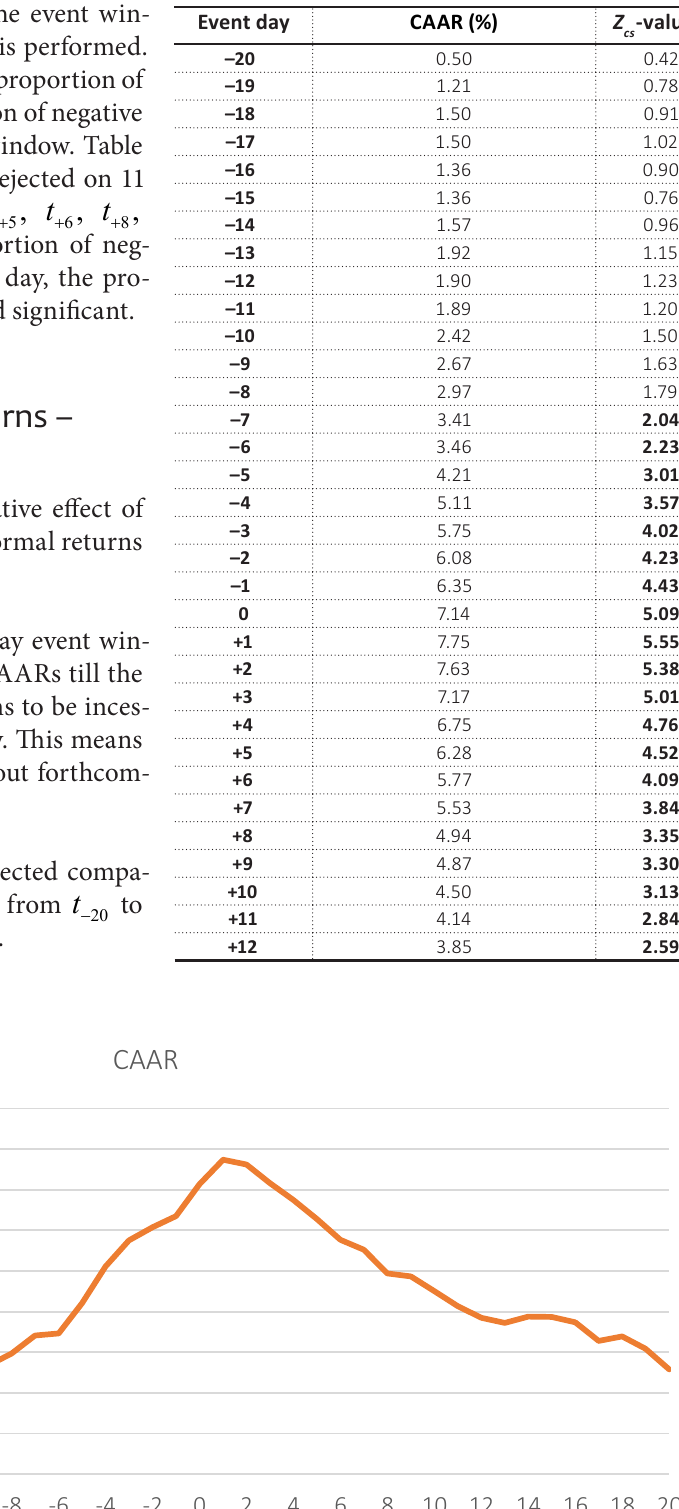
Table 2. CAARs and Z